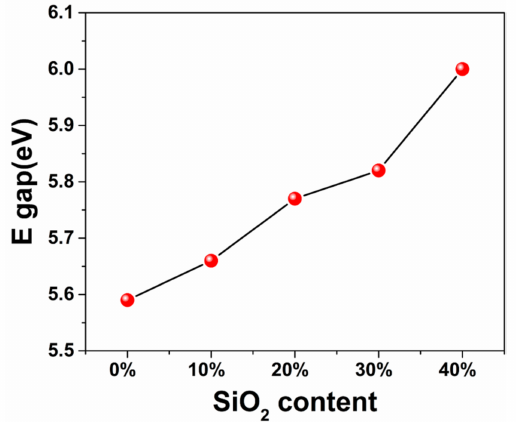
Figure 3. Bandgap of the Hf 1 − x Si x O 2 nanocomposite with different SiO 2